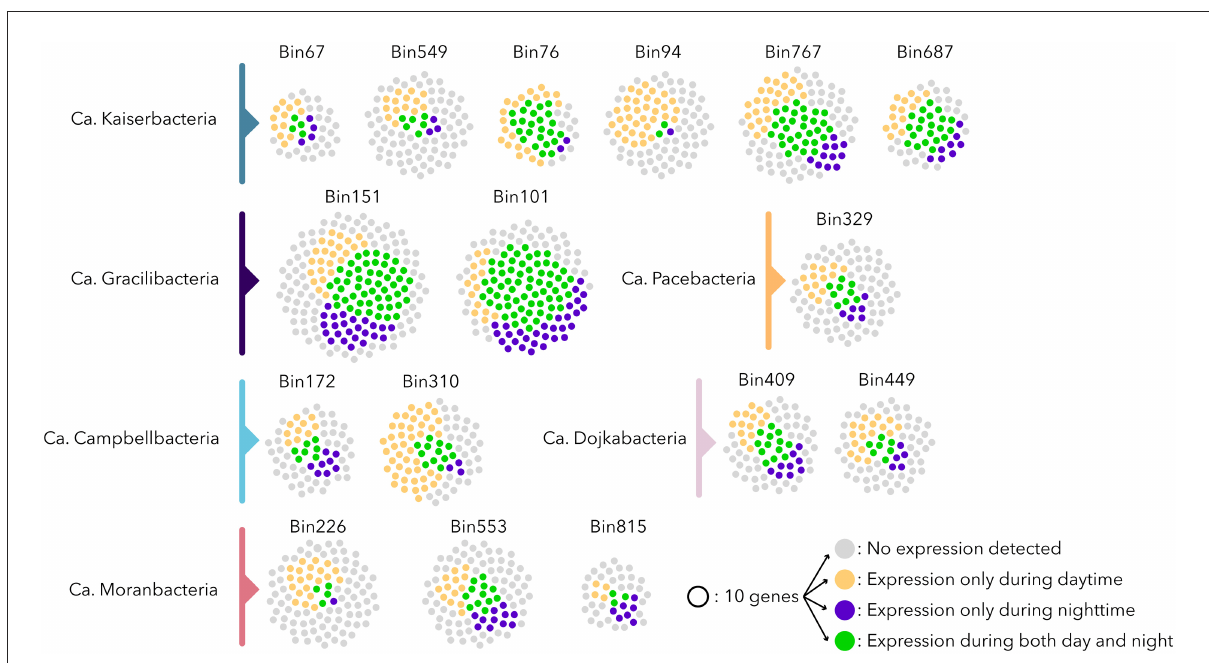
FIGURE4 Expression profile of the Patescibacteria populations. Each point represents 10 ORFs; gray points indicate no expression detected, and yellow and blue points represent genes expressed only during daytime and nighttime, respectively. Green points represent genes expressed during both daytime and nighttime. Bin272 and bin496 were omitted since they were recovered from samples collected in September 2011 without day/night